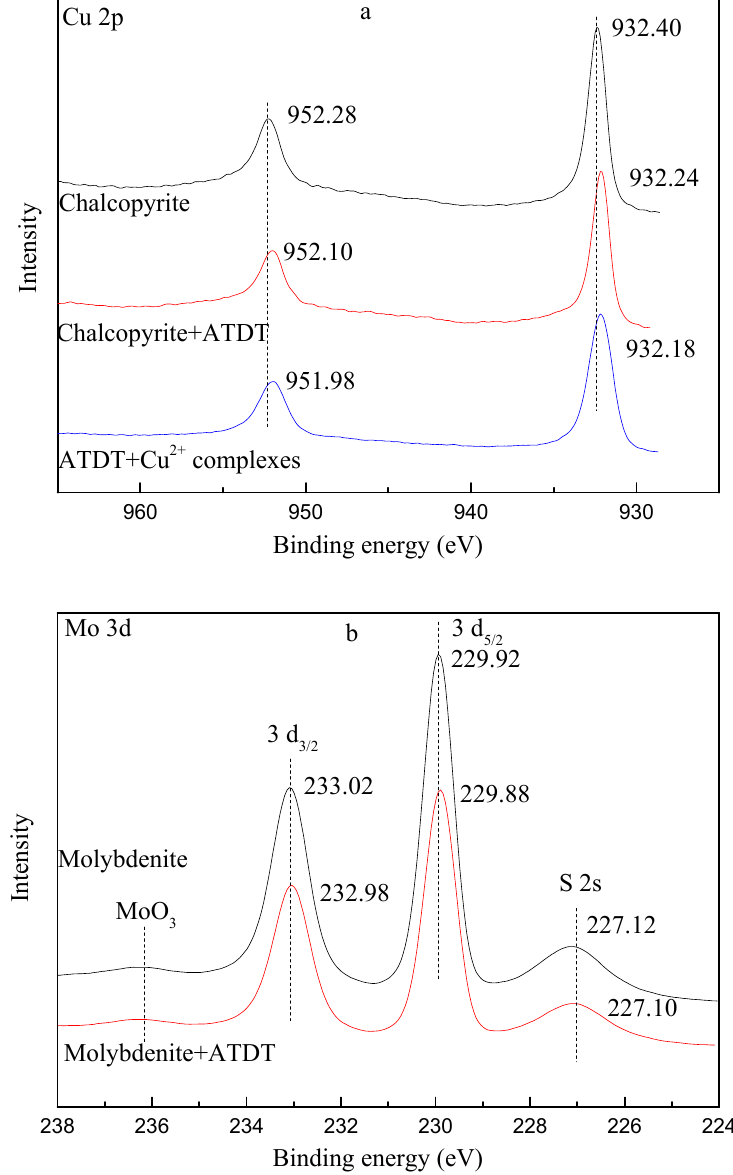
Figure 11. Cu 2p spectrum of ( a ) ATDT-Cu 2+ complexes, chalcopyrite before and after treatment; ( b ) Mo 3d spectrum of molybdenite before and after treatment.